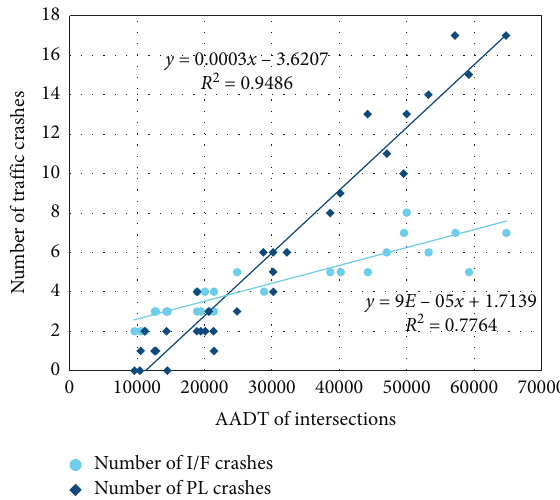
Figure 5: The relationship between the AADTof intersections and the number of property-loss/injury-or-fatal crashes.